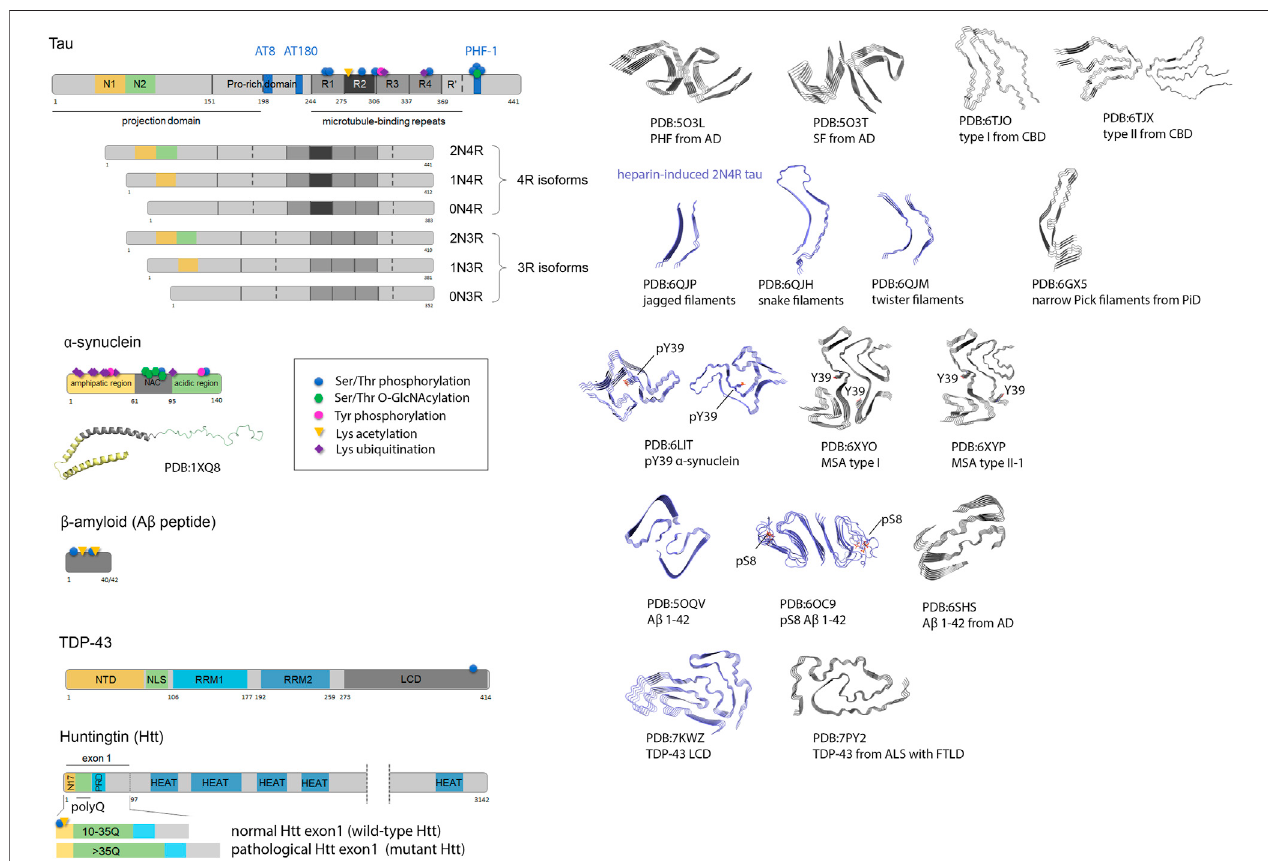
FIGURE 1 | Amyloid proteins involved in neurodegenerative diseases (tau, A β , α -synuclein, TDP-43 and Huntingtin), and their amyloid folds and polymorphs. Scheme of protein sequences highlighting domains, and eventually isoforms are presented (left). For tau protein, some prominent pathological phospho-epitopes (AT8, AT180, PHF-1) associated to tauopathies are indicated. N1, N2, N-terminal inserts; R1-R4, microtubule-binding repeats 1 to 4; NAC, non-amyloid- β component; NTD, N-terminaldomain;NLS,nuclearlocalizationsignal;RRM,RNARecognitionMotifs;LCD,lowcomplexitydomain;N17,17-residueN-terminalregion;PRD,proline- rich domain; polyQ, polyglutamine; HEAT, HEAT repeats. The solution NMR structure of micelle-bound α -synuclein is depicted. Some PTM sites studied by chemical ligation and/or chemical mutagenesis are indicated. The cryo-EM structures of representative fi brils from individual brains (grey structures) and synthetic fi brils (blue structures) highlight structural discrepancies pointing to the role of trans-acting cofactors and PTMs of amyloid proteins in the amyloidogenic process. For a more comprehensive description of the multiple tau folds associated to diverse tauopathies and their classi fi cation, refer to (Shi et al., 2021). AD, Alzheimer ’ s disease; CBD, corticobasal degeneration; PiD, Pick ’ s disease; MSA, multiple system atrophy; ALS with FTLD, amyotrophic lateral sclerosis with frontotemporal lobar